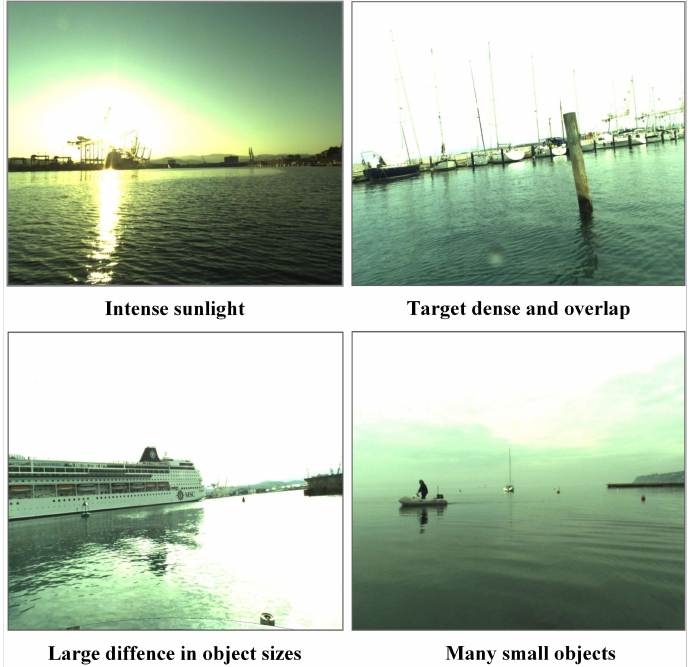
Figure 5. Characteristic analysis of MODD2 dataset.